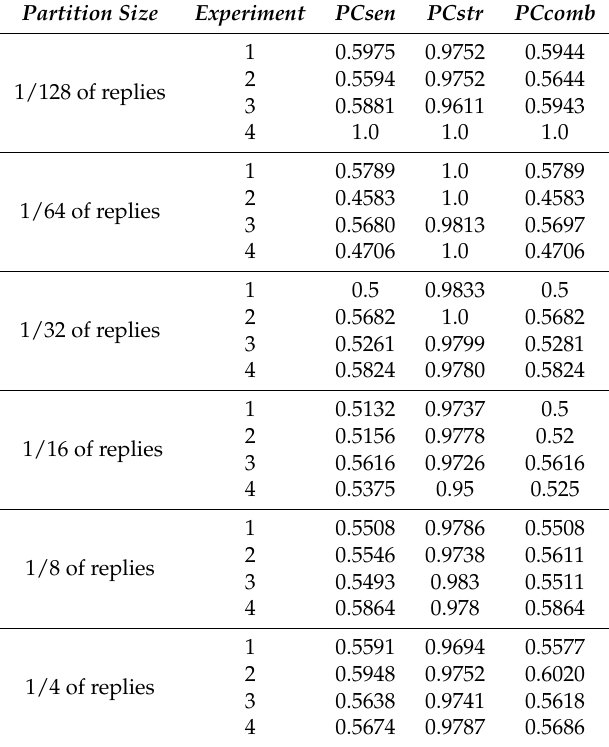
Table 1. Experimentation with the corpora Podemos.